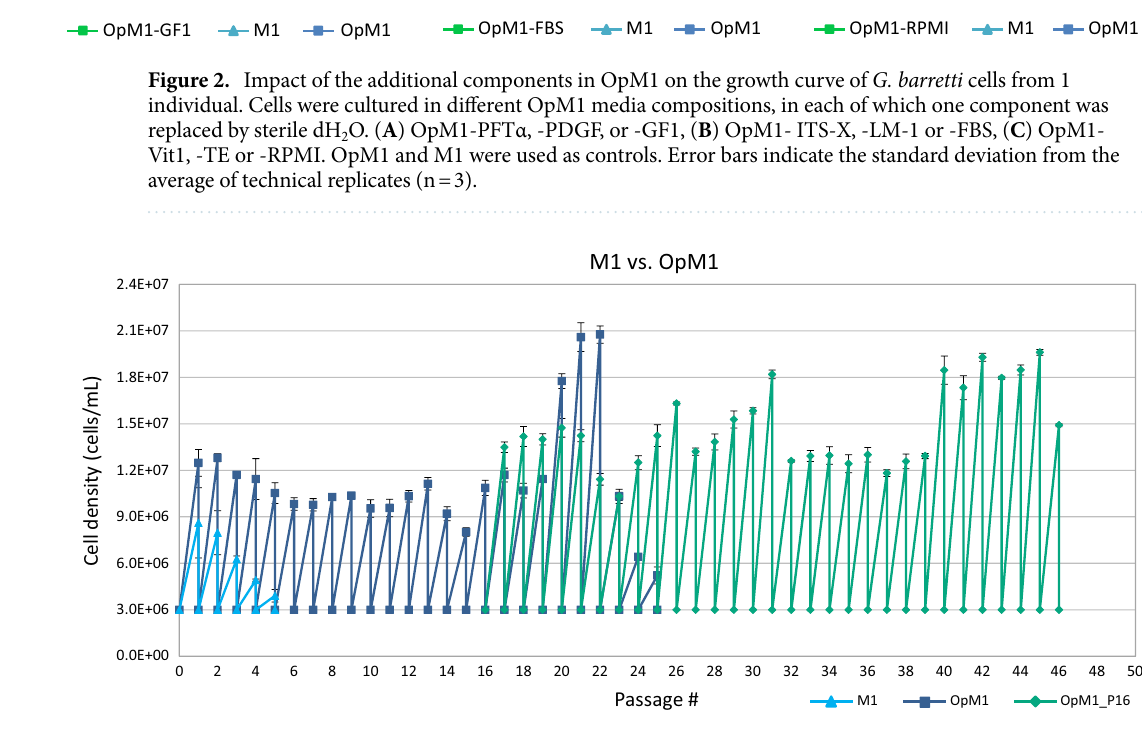
Figure 3. Passaging of G. barretti cells cultured in M1 and OpM1 media. OpM1_P16 represents cell cultures restarted from cells cryopreserved at passage 16. Error bars indicate the standard deviation from the average of biological (N = 3) and technical (n = 3)